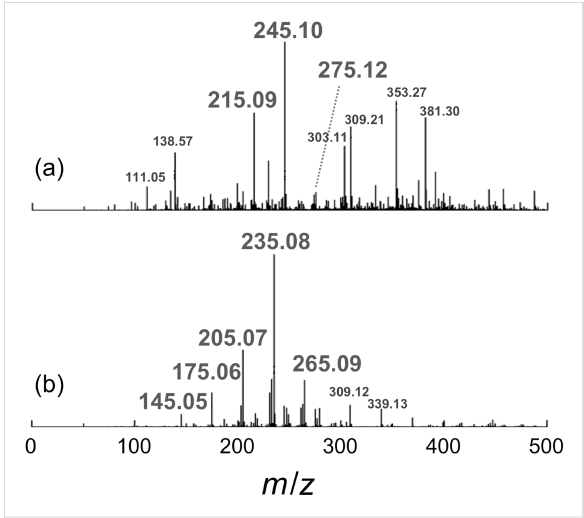
Figure 4: ESIMS data for the products of the formose reaction in the presence of 10 mM SPB (a) and 20 g L − 1 pVPB/NaSS (b); the reac- tion times were 90 and 180 min for (a) and (b),